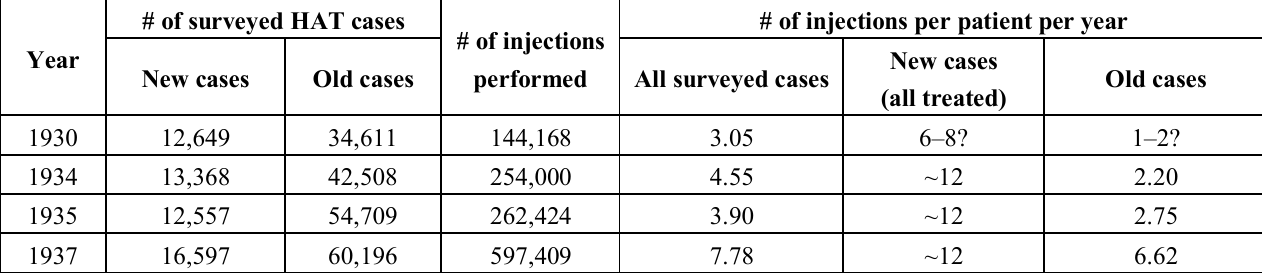
Table 2. Injections against human African trypanosomiasis (HAT) in Afrique